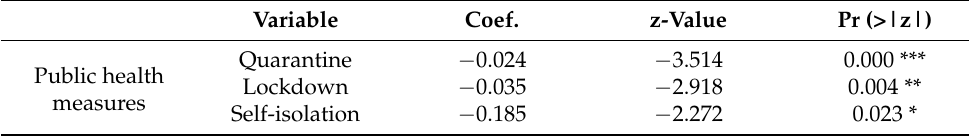
Table 8. Random effect partial results of states ranking 1 to 20. Variable Coef.